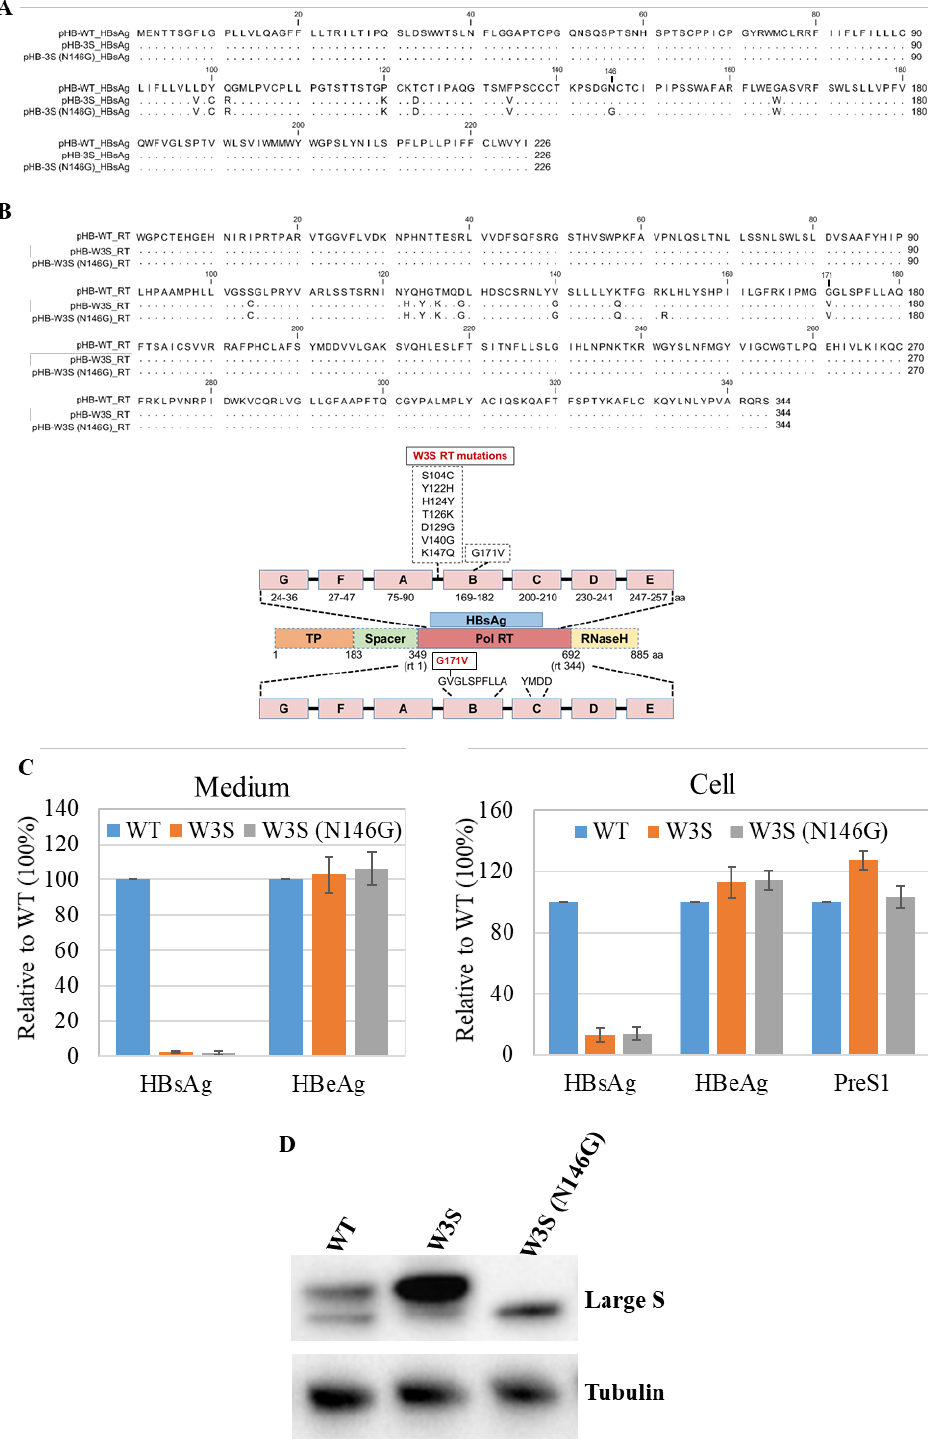
Figure 1. Amino acid mutations and antigen expression of HBV-WT, W3S, and W3S (N146G). ( A ) Alignment and comparison of the HBs amino acid sequences of WT, W3S, and W3S (N146G). ( B ) Upper: HBV pol RT amino acid sequence of WT, W3S, and W3S (N146G). Bottom: Relationship between HBs and HBV pol RT and mutations in the HBV-3S pol region. Identical amino acid residues are indicated by a dot. ( C ) Expression of HBsAg, HBeAg and preS1 (large S) in the soup and the cell. HBsAg, HBeAg, and preS1 ELISA were performed from 3 days post-transfection of HepG2 cells and/or medium. The results are presented as the average of three independent experiments with the standard deviation (SD). ( D ) Western blot analysis of cells at 3 days post-transfection using an antibody targeting the preS1